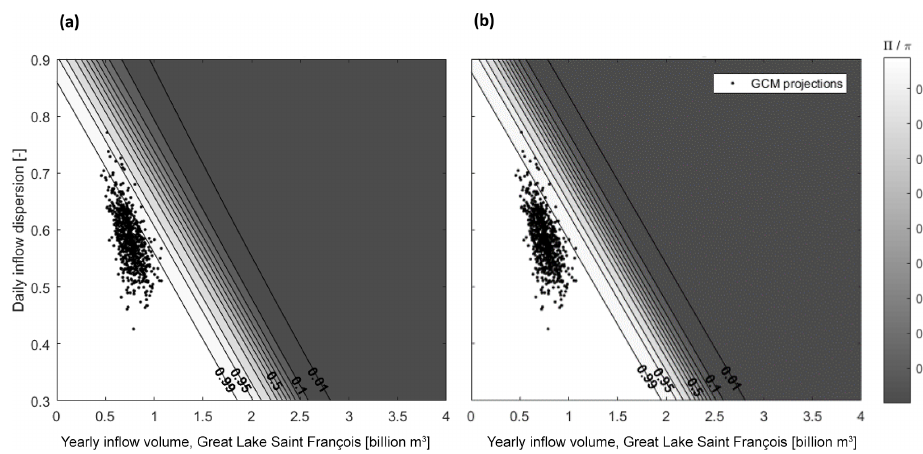
Figure 8. Logistic regressions and GCM projections (a) for fuzzy outcomes and (b) for binary outcomes.